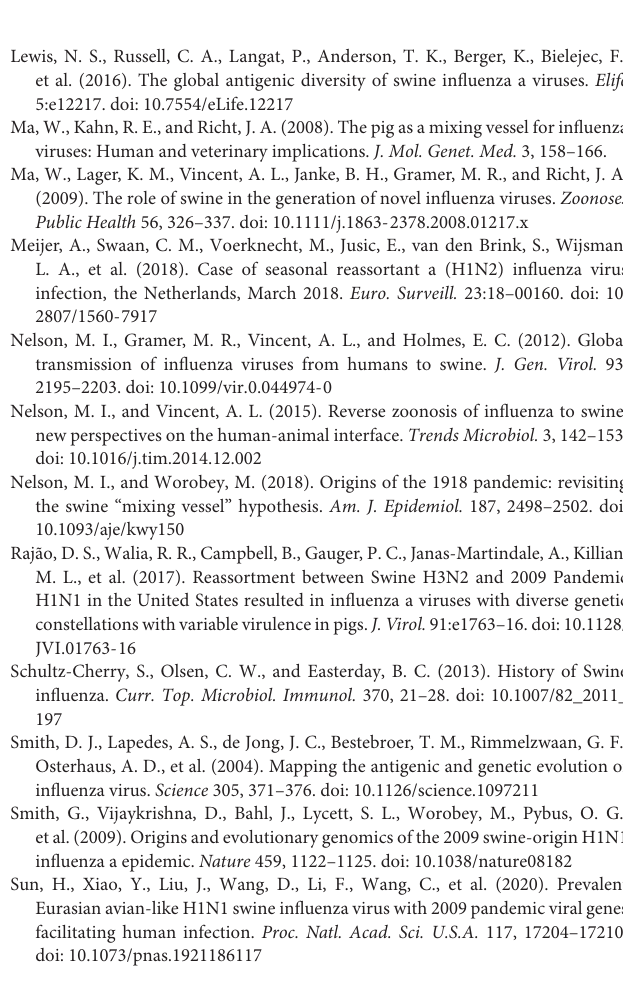
Supplementary Table 1 | GISAID accession numbers of viruses described in the study. Supplementary Table 2 | HA homology between different swine IAV